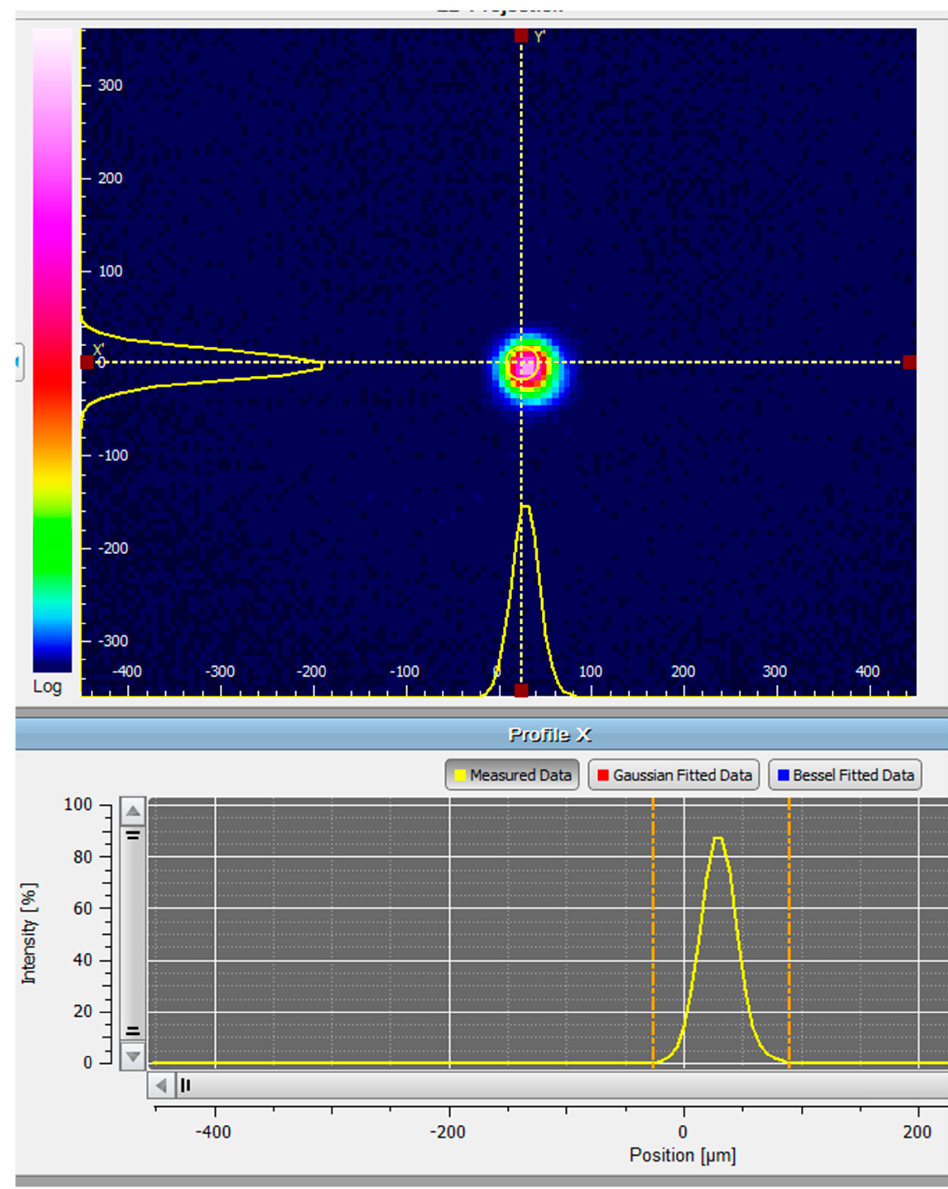
Figure 12. Incident bean intensity profile at a focal plane. f = 50 mm, z = 50 mm, FWHM = 32 μ m. Note, that the measurements include both spatial and angular shifts. While the contribution of the angular GH shift increases linearly as the beam propagates in accordance with ∆ x = z · tan ( δθ ) ≈ z · δθ , the lateral GH shift D is constant with the propagation distance z (Figure